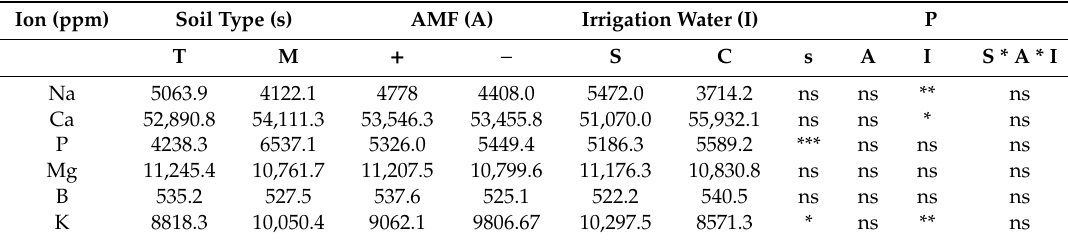
Table 3. Leaf mineral content according to variables including Soil type (s) (traditional: T and mixed: M), AMF inoculation (A) (with: + or without: − ), irrigation water (I) (saline: S, control: C), and interaction among them. Statistical significance according to one-way and three-way ANOVA tests. Values are means of three samples.